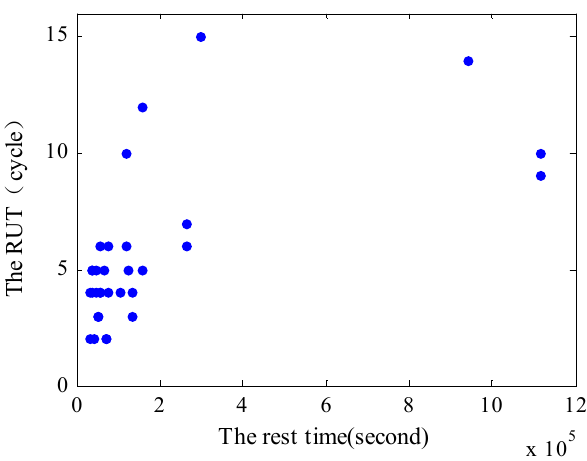
Figure 5. Data between the rest time and RUT.